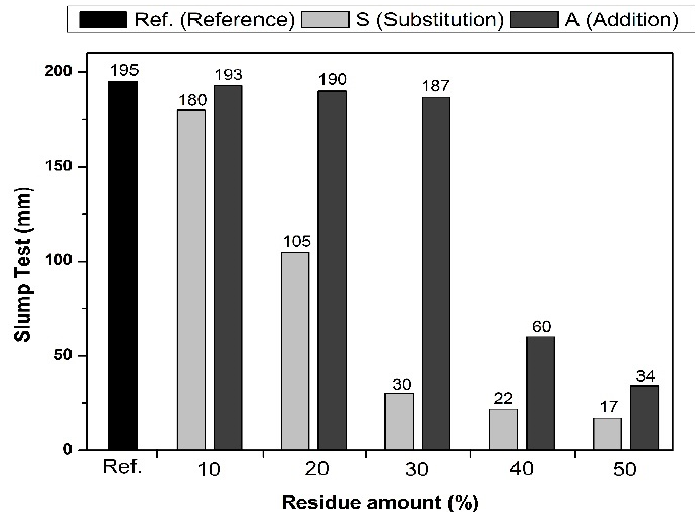
Figure 4. Workability values of all mixes by slump test.